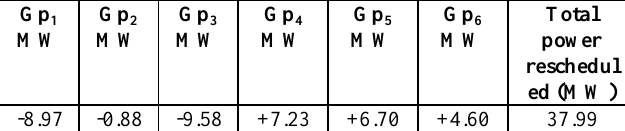
Table 7.Amount of power rescheduled (Case 1)